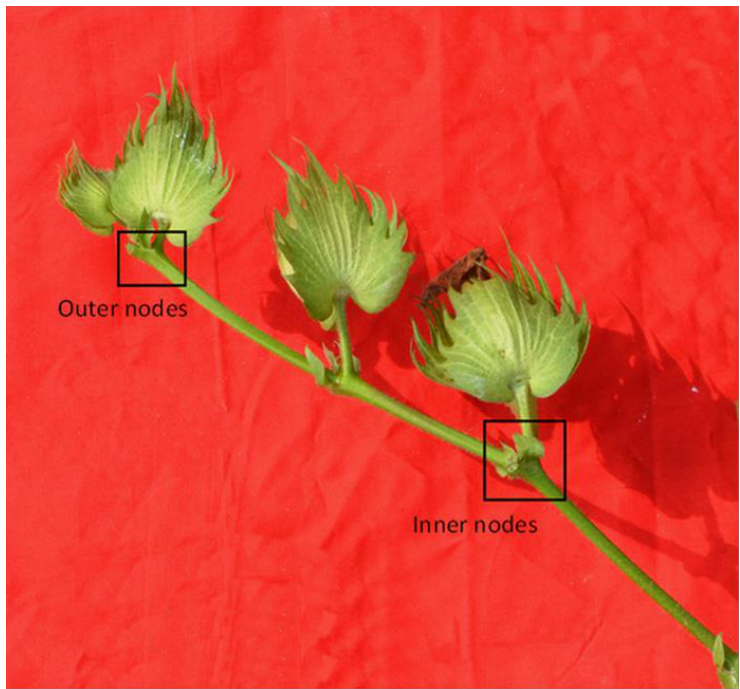
Figure 1. A sample of inner nodes, outer nodes, inner diameter, and outer diameter of a fruiting branch.